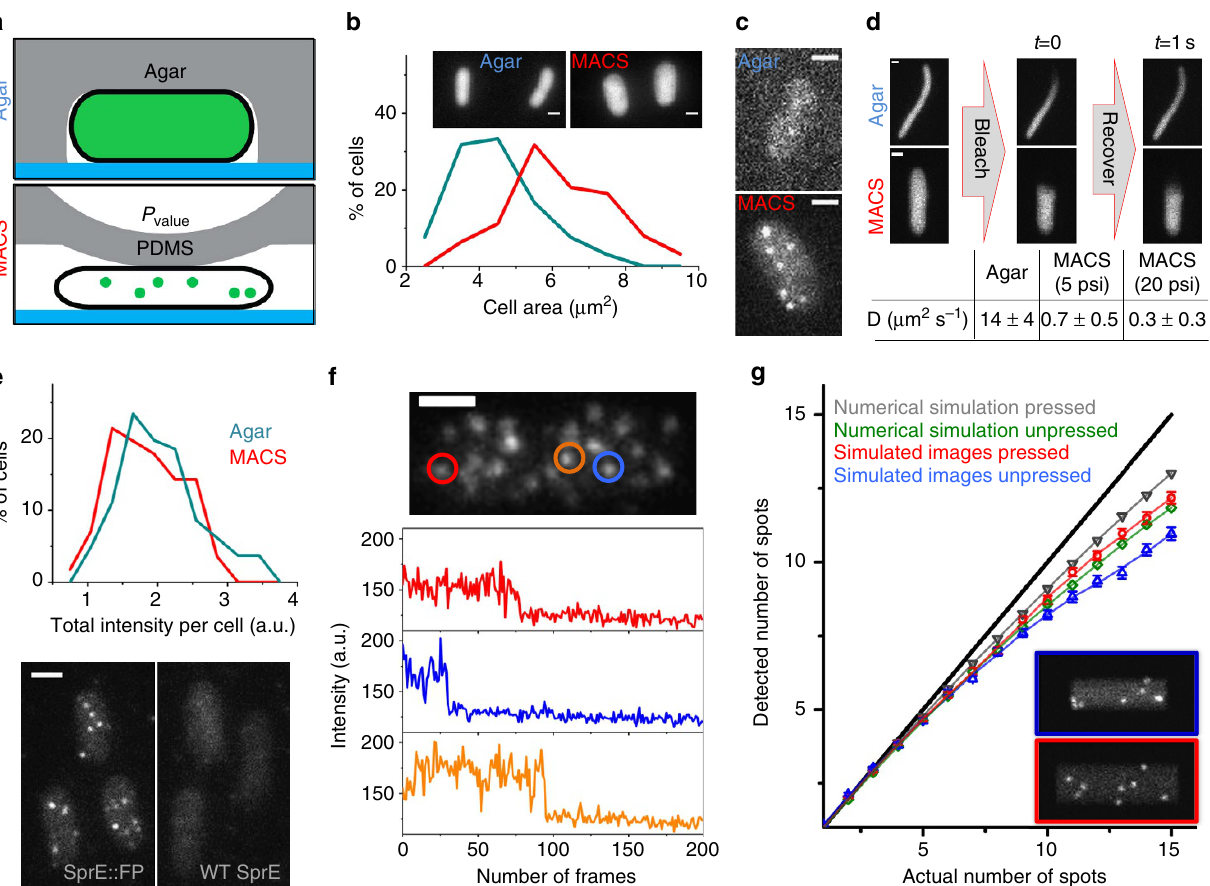
Figure 2 | Characterization of mechanical slowing-down and single-molecule counting on MACS. ( a – d ) MACS induces cell deformation and mechanical slowing-down of cytoplasmic proteins. ( a ) Cartoon depicting cell flattening and appearance of discrete spots (that is, single molecules, see below) for MACS versus agar pad imaging. ( b ) In comparison with agar, cells are flattened when imaged under MACS. ( c ) SprE tagged with mNeonGreen results in discrete spots on MACS as opposed to a diffuse signal on agar. ( d ) FRAP measurements quantify the extent of mechanical slowing-down on MACS as a function of P valve (Supplementary Fig. 4 and Supplementary Movies 4 and 5). Cells were treated with cephalexin and were thus elongated to enable FRAP measurements on agar, since FRAP occurred too rapidly to be measured otherwise. ( e – g ) Single-molecule counting is feasible with MACS. ( e ) Comparison of total intensities between agar and MACS imaging for the highly expressed segmentation marker (CFP) of the SprE-mNeonGreen strain suggesting that MACS does not cause signal loss. Comparing images of strains for FP-tagged versus wild-type SprE implies that the spots are specific to the mNeonGreen tagging of SprE. ( f ) Representative time traces of the SprE spots from one cell exhibiting single-step photobleaching (Supplementary Movie 6). ( g ) Undercounting due to spatial spot overlap in the cells was quantified using two independent computer simulations. First, a numerical simulation was carried out considering that the Euclidian distance between the spots be smaller than the diffraction-limited resolution (Supplementary Methods and Supplementary Fig. 6). The second simulation used computer-generated images, which were then analysed using the spot-finding code (Supplementary Methods and Supplementary Fig. 7). Inset shows two representative simulated images for unpressed (top) versus pressed (bottom) cells with an actual number of spots ¼ 8 (Supplementary Fig. 8). The results of both simulations suggest that pressing on the cells would moderately remedy undercounting. All scale bars (white) are 1 m